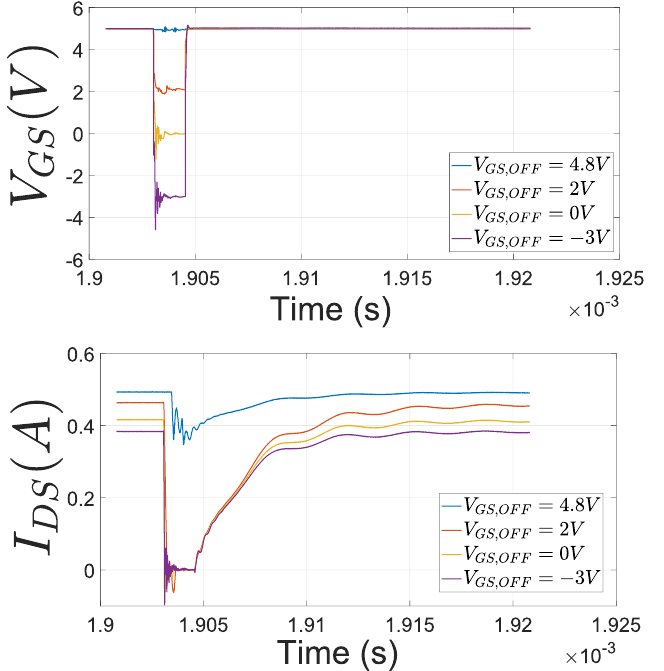
Figure 8. V GS ( up ) and I DS ( down ) waveforms in case of null blocking voltage at 25 ◦ C. The displayed time interval starts 5 µ s before the trigger event and ends 20 µ s after the trigger